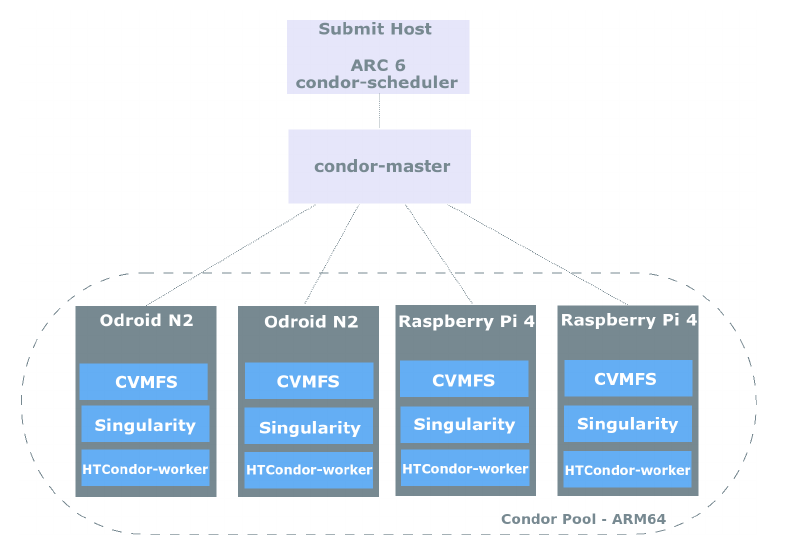
Figure 1. The ARM software